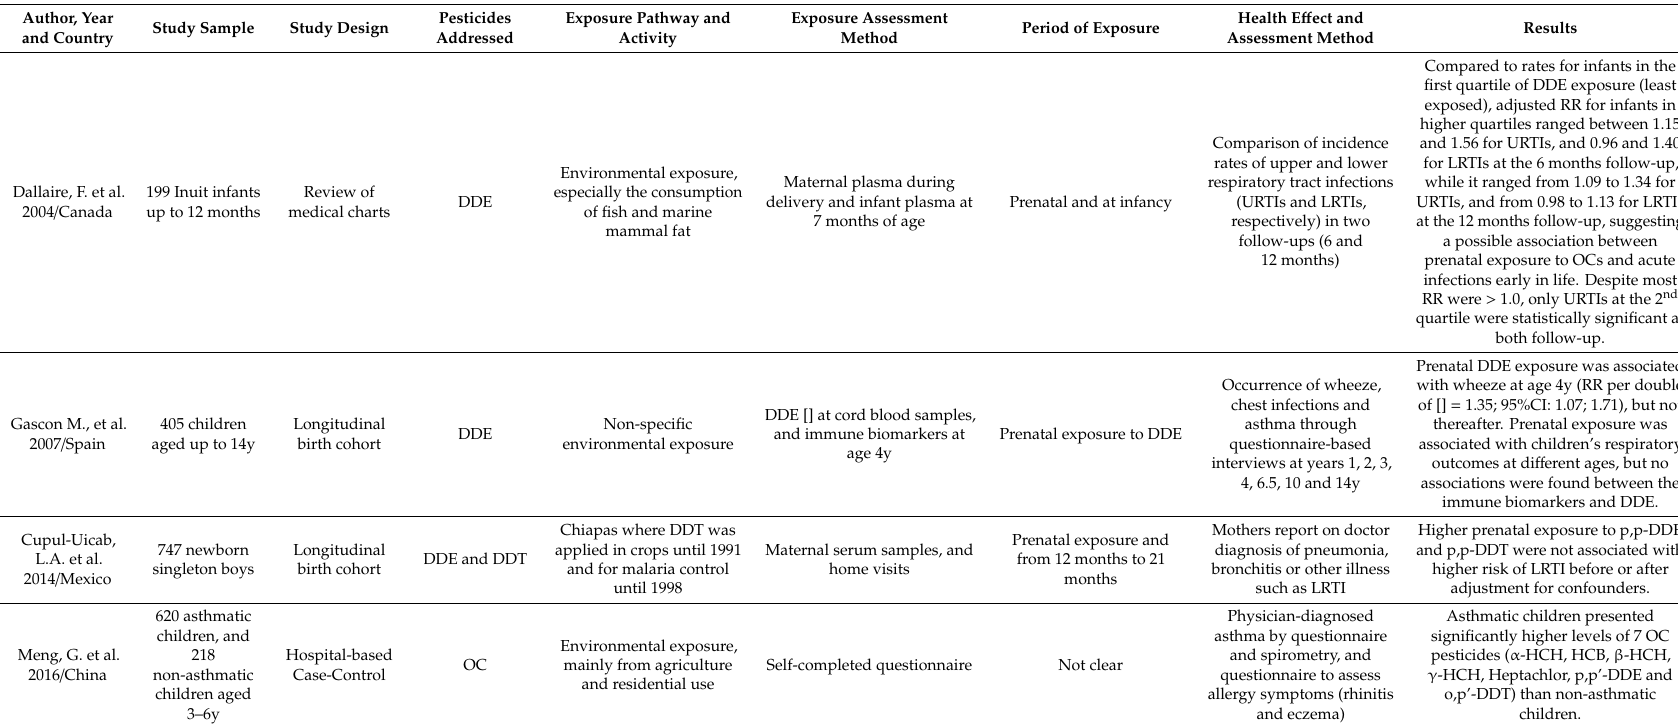
Table 2. Studies on respiratory and allergic e ff ects of organochlorine pesticides (OC) in